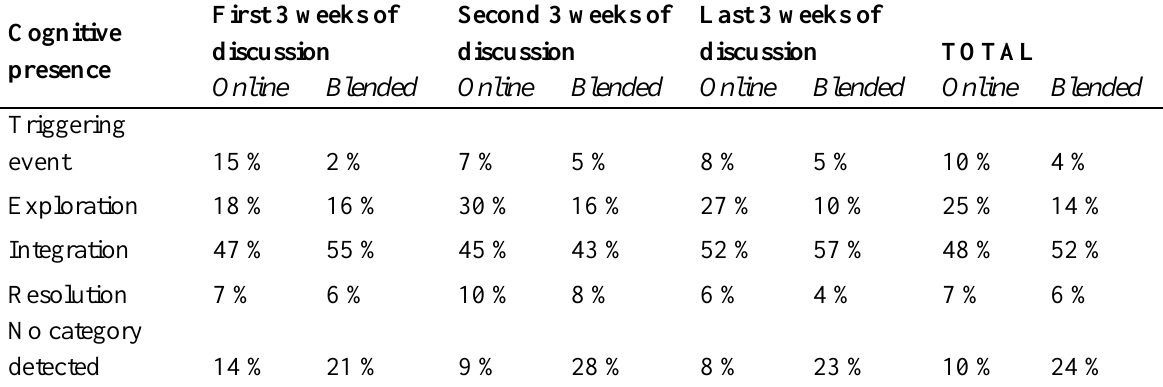
Table 3 Comparison of Coding Results for Cognitive Presence within Three Time Periods First 3 weeks of Second 3 weeks of Last 3 weeks of Cognitive discussion discussion presence Online Online Online Blended Online Blended Triggering